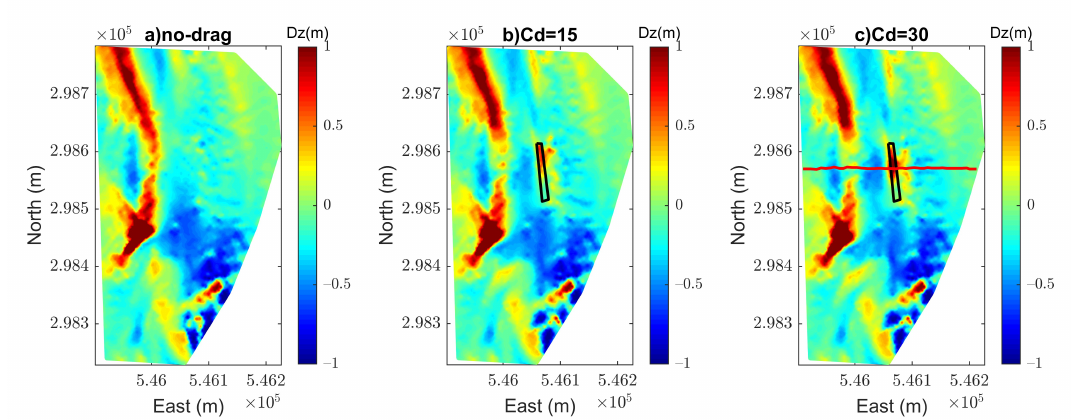
Figure 11. Erosion/sedimentation with different drag coefficients: ( a ) without drag coefficient Cd = 0; ( b ) with drag coefficient Cd = 15; ( c ) with drag coefficient Cd = 30. The black line depicts the location of the SND and the red line indicates location of transect T2. Postive values of Dz indicates sedimentation whereas negative values indicate erosion.